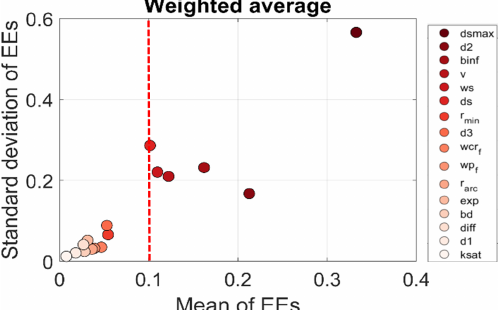
Figure 5. Sensitivity indices (mean and standard deviation) of the Morris method for VIC-3L parameters for the Mahanadi river basin (computed based on weighted average of all subcatchments). Pa- rameters, top to bottom, listed on the right side are in ranking or- der, highest to lowest influential parameters, respectively, based on mean of EEs. The dashed red vertical line is the screening